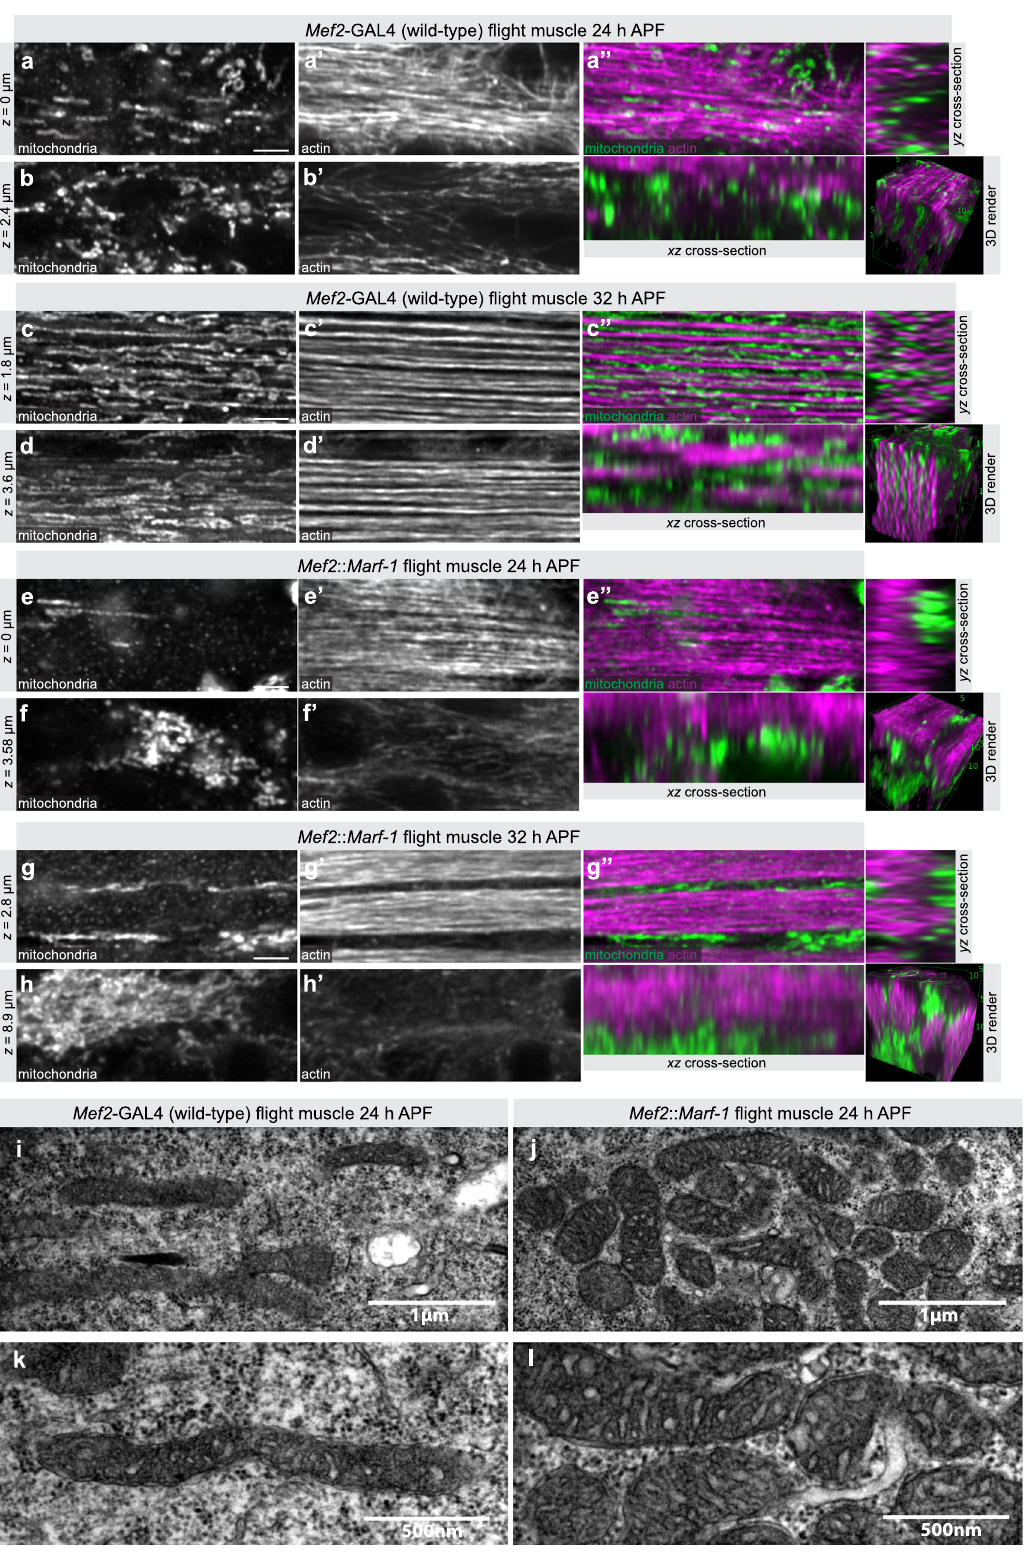
Fig. 7 Developmental effect of mitochondria hyper-fusion. a – h Developing wild-type fl ight muscles at 24 h after puparium formation (APF) ( a , b ) and 32 h APF ( c , d ), compared to Mef2::Marf-1 fl ight muscles at 24 h APF ( e , f ) and 32 h APF ( g , h ). See also Supplementary Movie 8. Mitochondria were visualised with mito-GFP and actin with phalloidin. Note the mitochondrial intercalation between myo fi brils in wild-type 32 h APF fl ight muscles ( c ″ ), which is blocked by Mef2::Marf-1 ( g ″ ). i – l Developing wild-type ( i , k ) compared to Mef2 :: Marf-1 ( j , l ) fl ight muscles at 24 h APF visualised by electron microscopy (EM). Two representative regions at different magni fi cations are shown. Note the clustered and more rounded mitochondria upon Mef2 :: Marf-1 . Scale bars are 2.5 µ m ( a – g ) or directly noted on EM images ( i – l